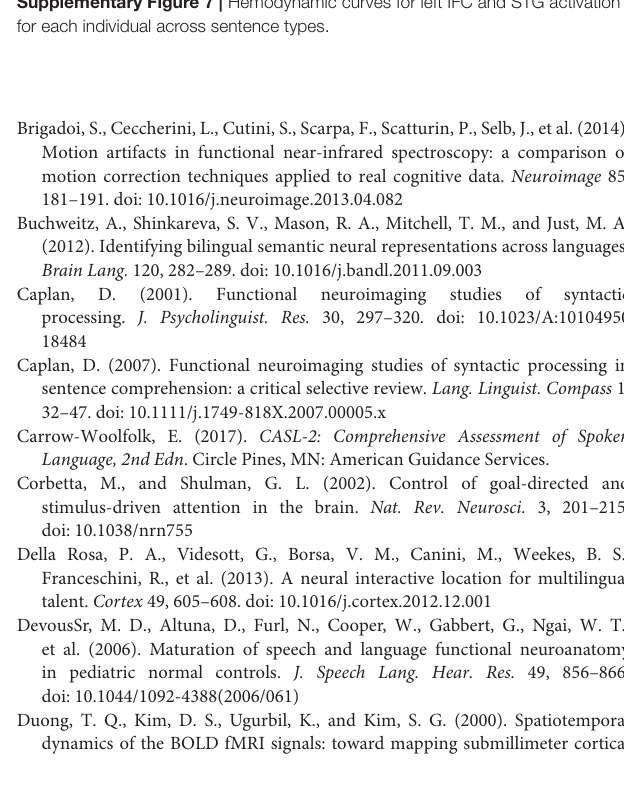
Supplementary Figure 1 | Deoxyhemoglobin curves for monolingual and bilingual adults. Supplementary Figure 2 | Oxyhemoglobin curves for monolingual and bilingual adults. Supplementary Figure 3 | Deoxyhemoglobin curves for bilingual children and adults. Supplementary Figure 4 | Oxyhemoglobin curves for bilingual children and adults. Supplementary Figure 5 | Deoxyhemoglobin curves for monolingual and bilingual children. Supplementary Figure 6 | Oxyhemoglobin curves for monolingual and bilingual children. Supplementary Figure 7 | Hemodynamic curves for left IFC and STG activation for each individual across sentence